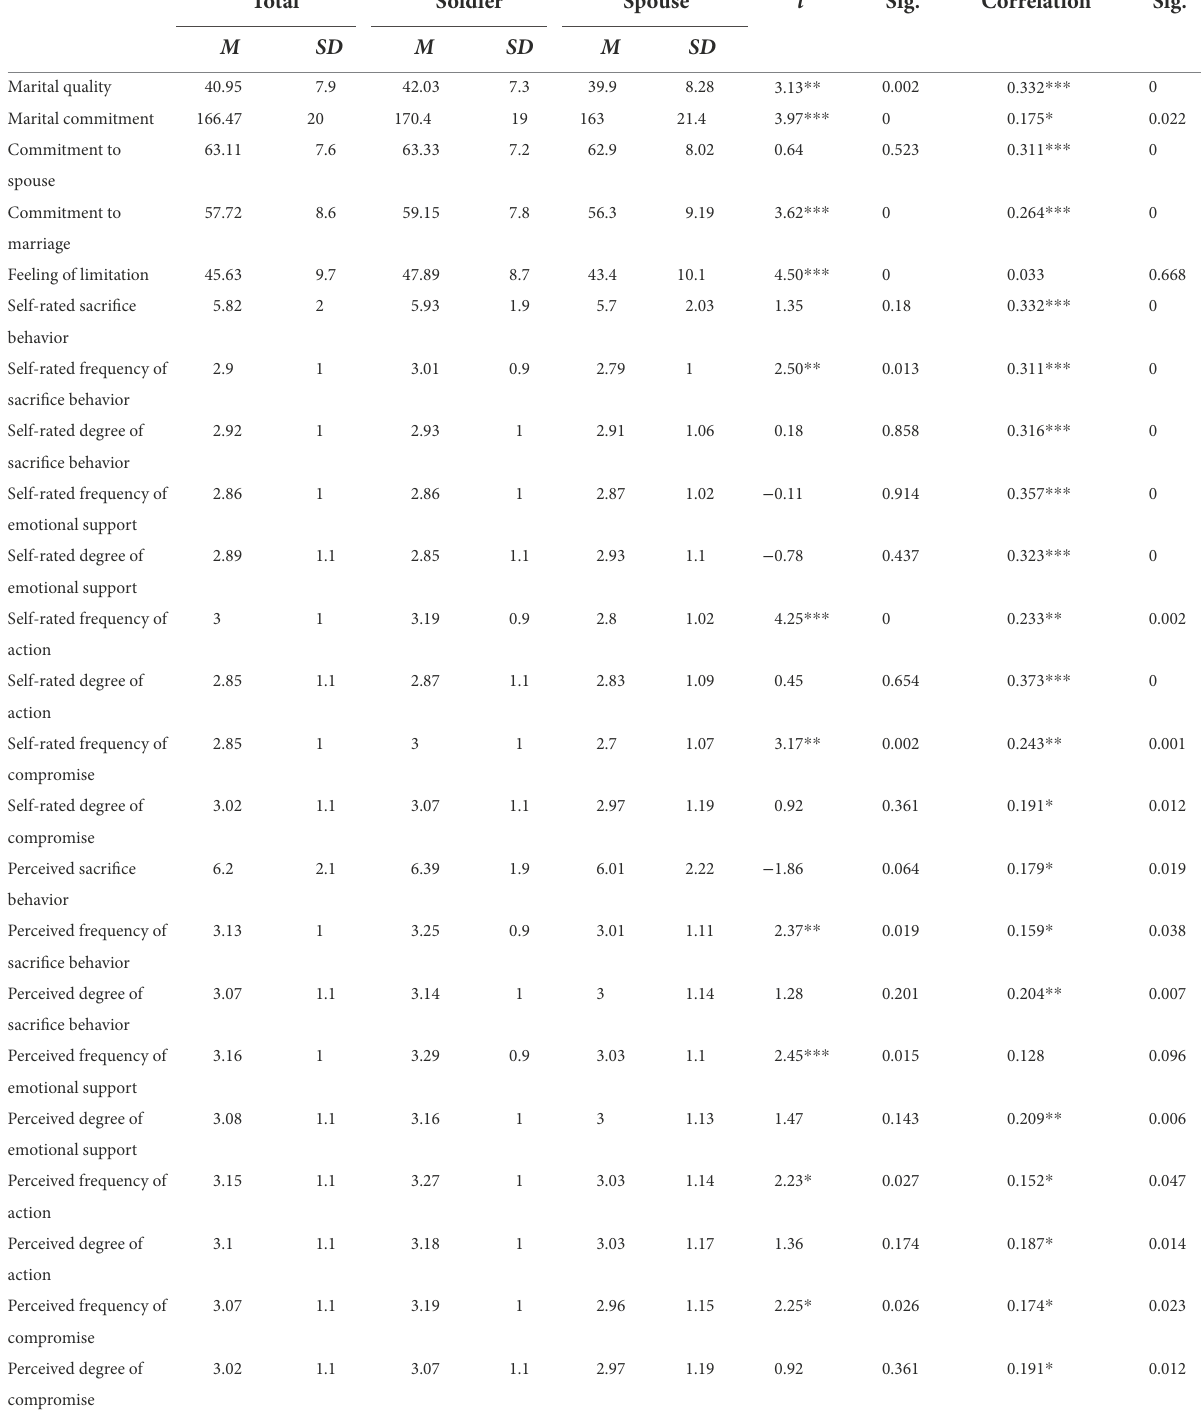
TABLE 2 Differences and correlations of marital commitment, sacrifice behavior and marital quality of soldiers and their spouses. Total Soldier Spouse t Sig. Correlation